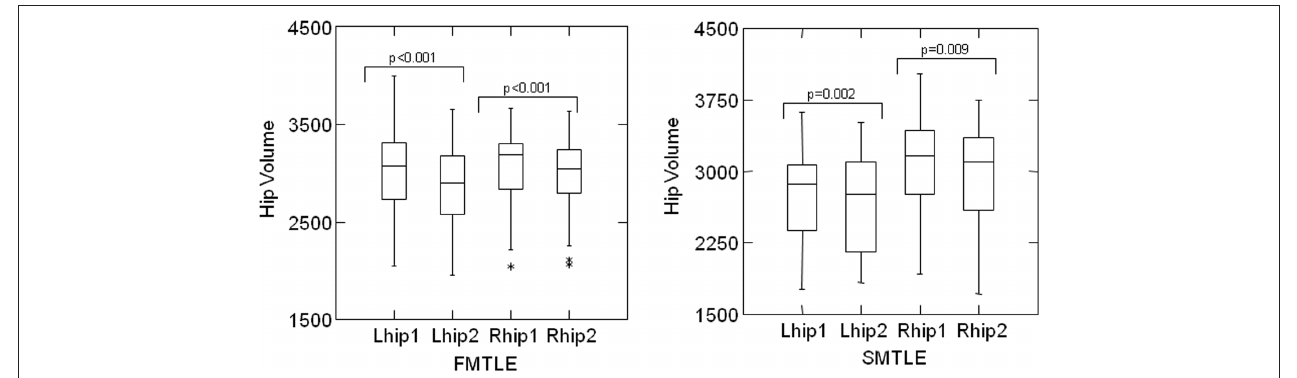
significant reduction of the right and left hippocampal volumes during the follow-up period in FMTLE and SMTLE groups. Lhip1, left hippocampus in the first MRI; Lhip2, left hippocampus in the second MRI; Rhip1, right hippocampus in the first MRI; Rhip2, right hippocampus in the second MRI.